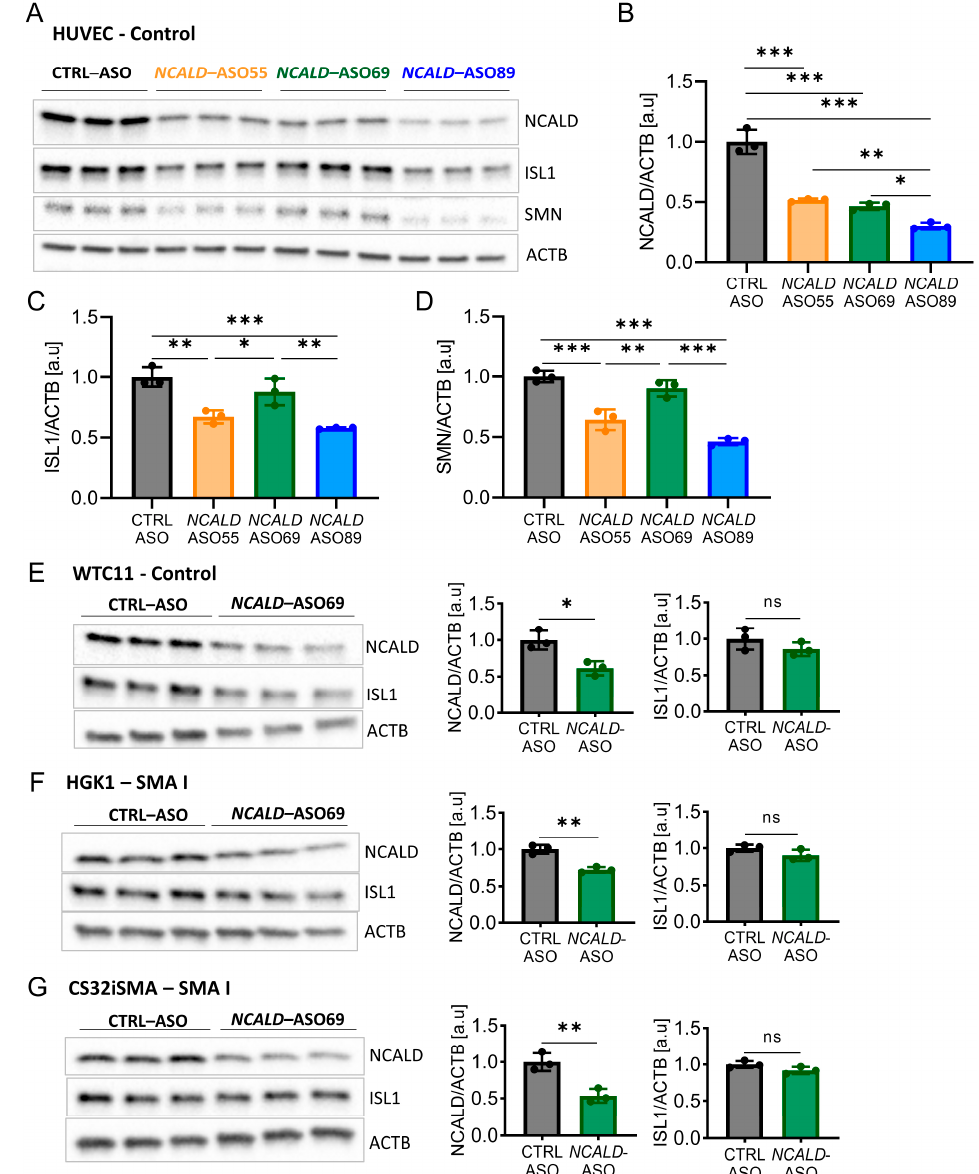
Figure 3. Efficiency and tolerability of NCALD -ASO candidates 7 days after treatment in hiPSC-derived MNs. ( A ) Western blot of HUVEC hiPSC-derived MNs treated with 60 nM of CTRL-ASO or the respective NCALD -ASO candidate using Lipofectamine™ at day 13, proteins collected at day 20 of the differentiation. ACTB used as loading control. ( B ) Quantification of NCALD levels in HUVEC MNs at day 20 after treatment with different NCALD -ASOs. Ordinary one-way ANOVA with Tukey post hoc test for multiple comparisons. ( C ) Quantification of ISL1 levels in HUVEC MNs at day 20 after treatment with each NCALD -ASOs. Ordinary one-way ANOVA with Tukey post hoc test for multiple comparisons. ( D ) Quantification of SMN levels in HUVEC MNs at day 20 after treatment with each NCALD -ASOs. Ordinary one-way ANOVA with Tukey post hoc test for multiple comparisons. ( E – G ) Western blots of control WTC11 ( E ), SMA type I HGK1 ( F ) and SMA type I CS32iSMA ( G ) MNs treated at day 13 of the differentiation with 60 nM of CTRL-ASO or NCALD -ASO69 using Lipofectamine™. Proteins were collected at day 20 of the differentiation. NCALD protein levels are significantly reduced upon NCALD -ASO69 treatment in all lines. No significant reduction of ISL1 protein and thus impact on MNs was detected. Unpaired two-tailed Student’s t -test was performed. All values reported as mean and error bars represent ± SD. N = 3, each dot in the bar graphs represents an independent well. * p ≤ 0.05, ** p ≤ 0.01, *** p ≤ 0.001. ns = not